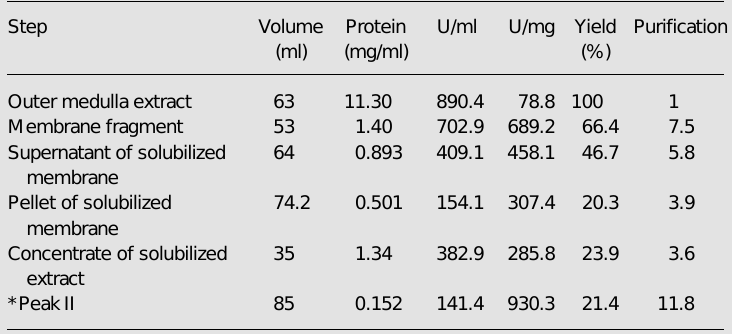
Table 1. Extraction, C 12 E 8 solubilization and purification steps of an Na,K-ATPase from rabbit kidney outer medulla.